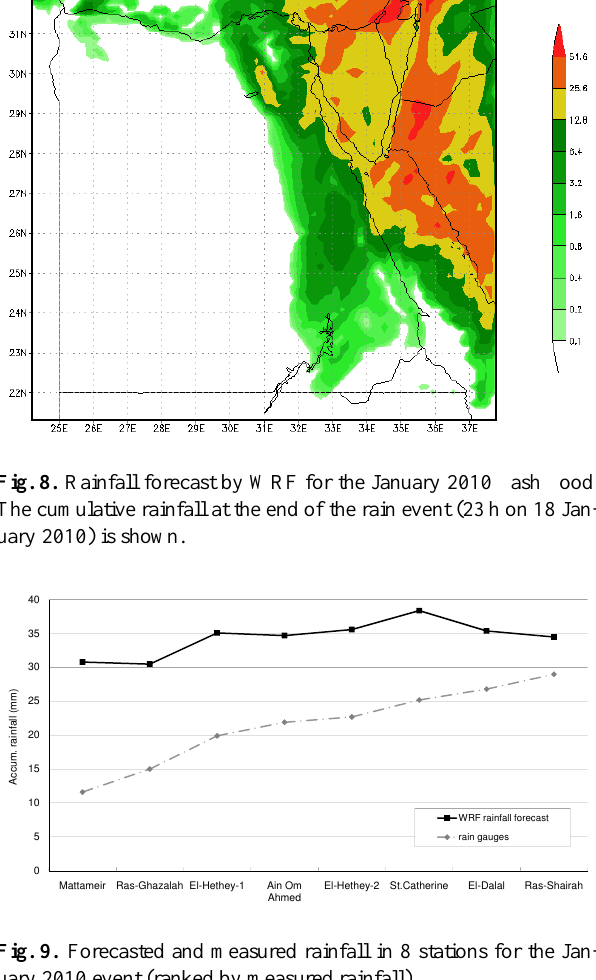
Fig. 11. Forecasted and measured rainfall for the October 2008 event (Sorah